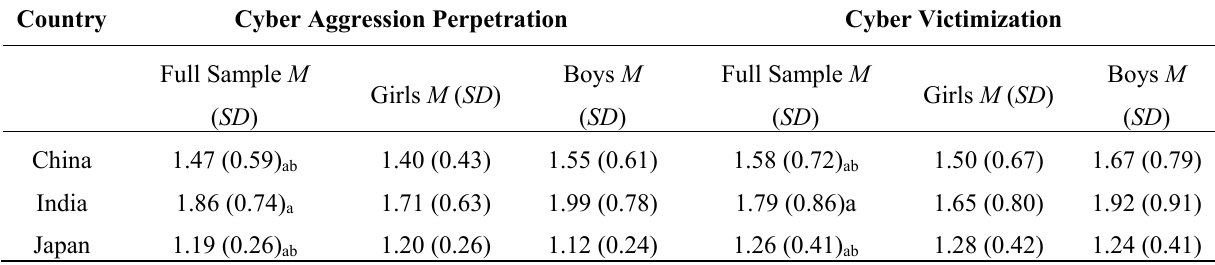
Table 2. Means and standard deviations of cyber aggression perpetration and victimization for China, India, and